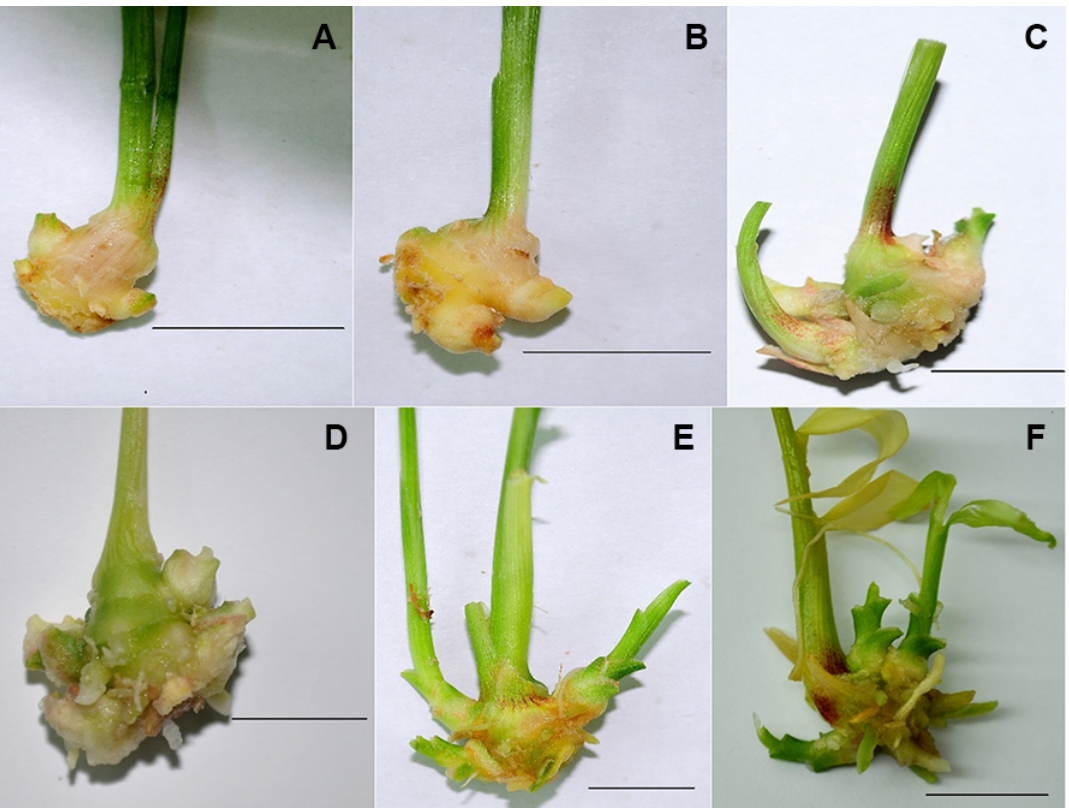
Figure 1 The typical microrhizomes produced by plantlets cultured in MS medium supplemented with 80 g/L sucrose ( A ), 80 g/L sucrose and 1.9 mg/L AgNO 3 ( B ), 80 g/L sucrose, 1.9 mg/L AgNO 3 , and 4 mg/L BAP (6-benzylamino purine) ( C ), 80 g/L sucrose, 1.9 mg/L AgNO 3 , and 6 mg/L NAA ( α -naphthaleneacetic acid) ( D ), 80 g/L sucrose, 1.9 mg/L AgNO 3 , and 4 mg/L IBA (indole-3-butyric acid) ( E ), 80 g/L sucrose, 1.9 mg/L AgNO 3 , and 550 mg/L NH 4 NO 3 ( F ). Scale bars: 10 mm.